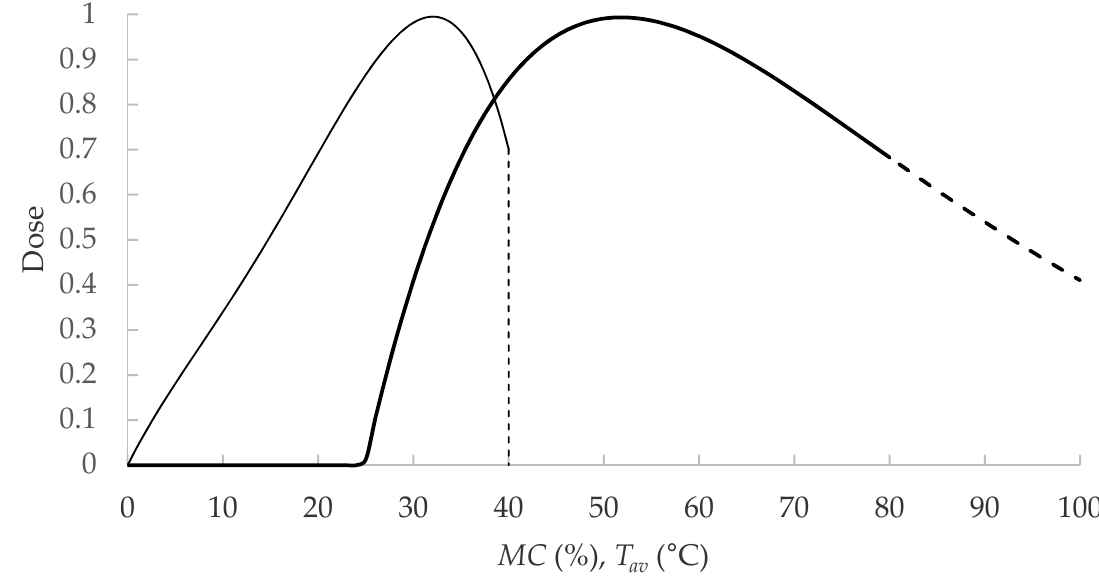
Figure 3. Relationship between MC and daily moisture-induced dose d MC (thick line), and between average wood temperature T av and daily temperature-induced dose d T (thin line), respectively. Thick dashed line: MC (80% did not occur; therefore, the curve progression is uncertain)—with permission from [23].